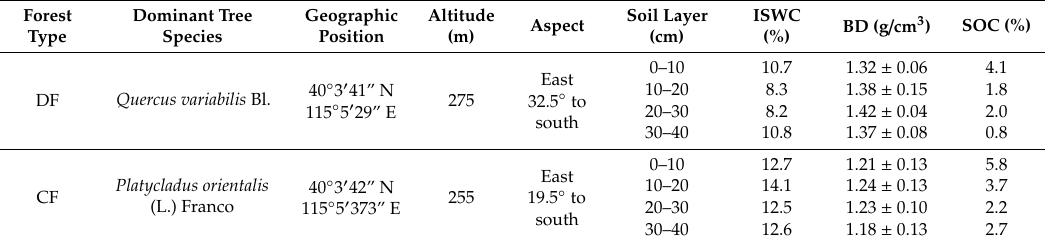
Table 1. Characteristics of the two experimental study sites and soil physicochemical properties in the 0–40 cm soil